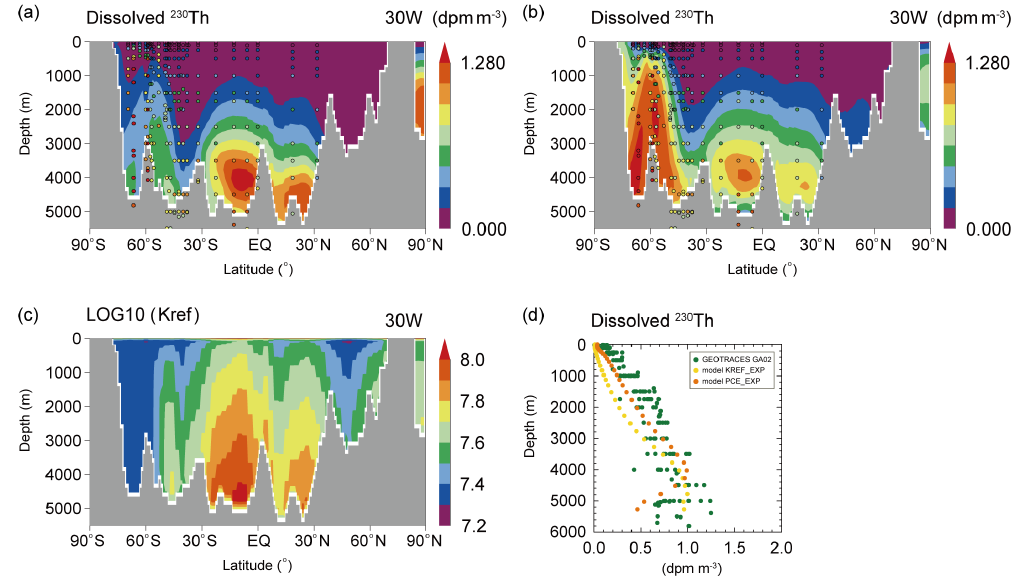
Figure 5. Dissolved 230 Th along 30 ◦ W in the Atlantic Ocean in (a) R6_B5 of the KREF_EXP and (b) PCE_EXP. (c) Reference partition coefficient (K_ref) along 30 ◦ W in the Atlantic Ocean in PCE_EXP. (d) The vertical profile of dissolved 230 Th (the latitudinal mean along 30 ◦ W in the Atlantic Ocean) in R6_B5 of KREF_EXP and PCE_EXP. The colored circles in (a) and (b) represent data from the Atlantic GEOTRACES data (GA02 and GIPY05; Schlitzer et al., 2018). The green, yellow, and orange circles in (d) represent the GA02 data and KREF_EXP and PCE_EXP simulation